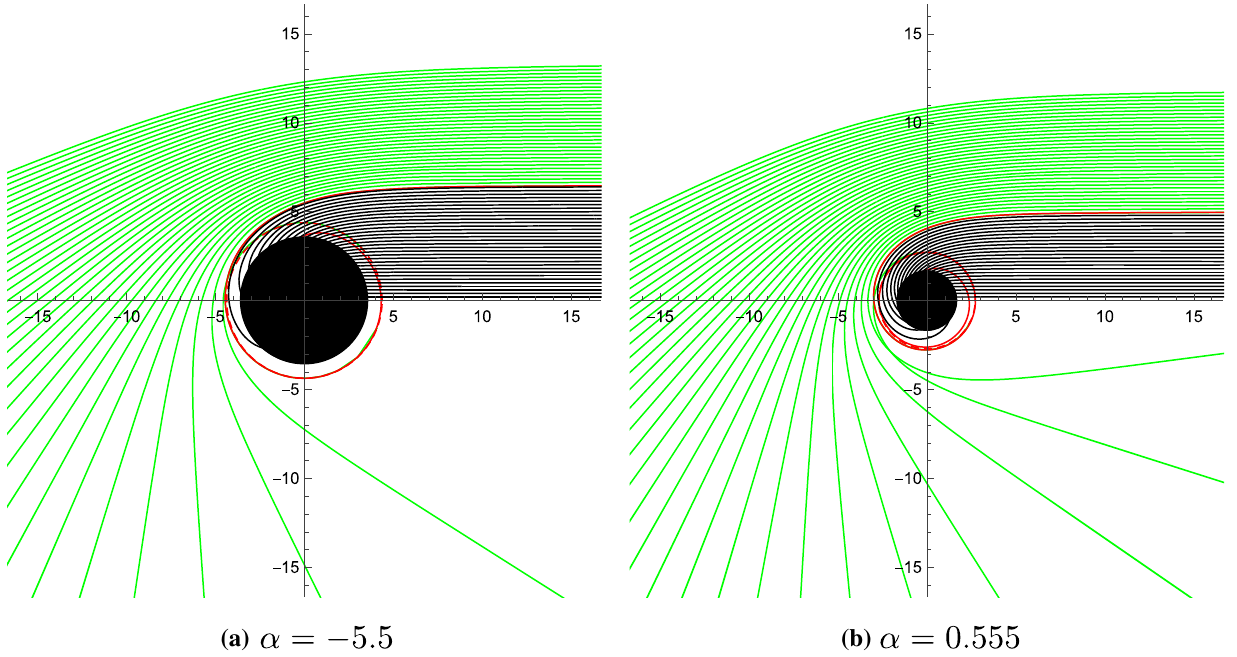
Fig. 2 The trajectory of the light ray for different α with M = 1 in the polar coordinates ( r ,φ) . The red line corresponds to b = b ph , the black line corresponds to b < b ph , and the green line corresponds to correspond to b < b ph , b = b ph and b > b ph ,